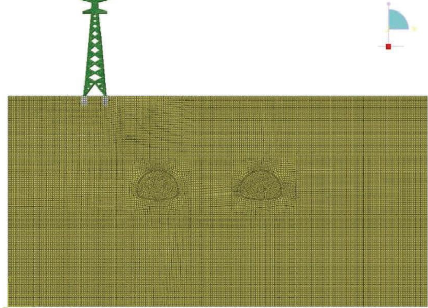
Figure 4: Schematic diagram of numerical